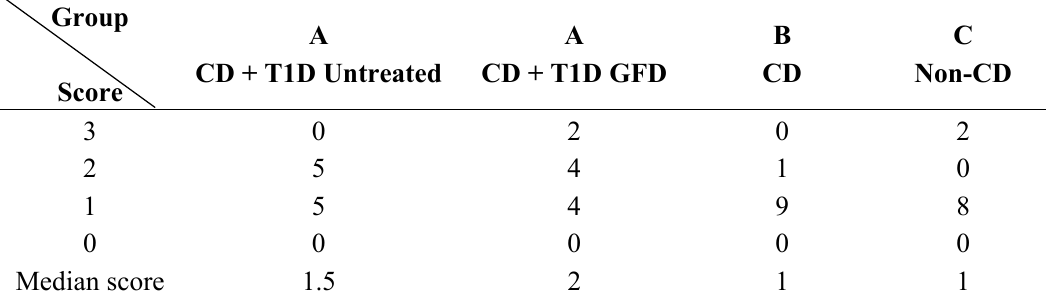
Table 2. Peanut agglutinin staining scores. Stained sections of biopsies from patients in Groups A (before and after remission), B, and C were scored as follows: 0 represents no staining of the epithelial cell layer, 1 represents staining in the cytoplasm of epithelial cells, 2 represents staining of cytoplasm and glycocalyx, and 3 represents staining of cytoplasm and glycocalyx, as well as goblet cells.